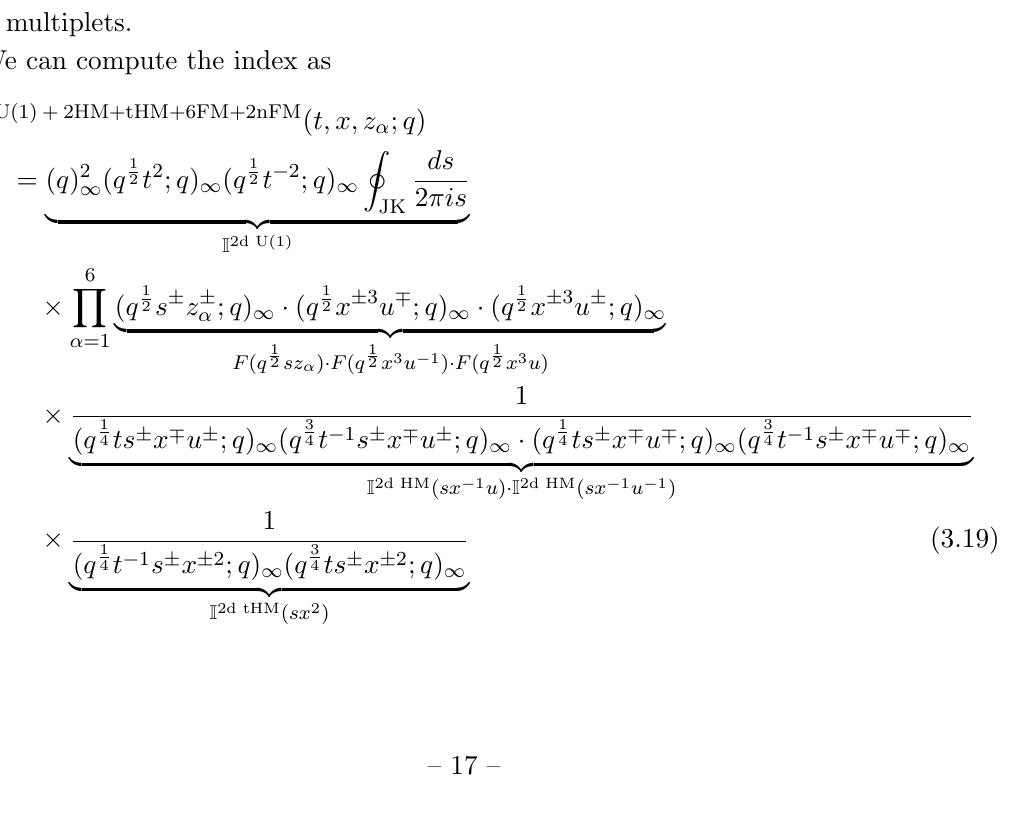
Figure 4 . The brane box configuration of 2d hypermultiplets, a charged twisted hypermultiplet, six charged Fermi multiplets and two neutral Fermi multiplets and the S-dual